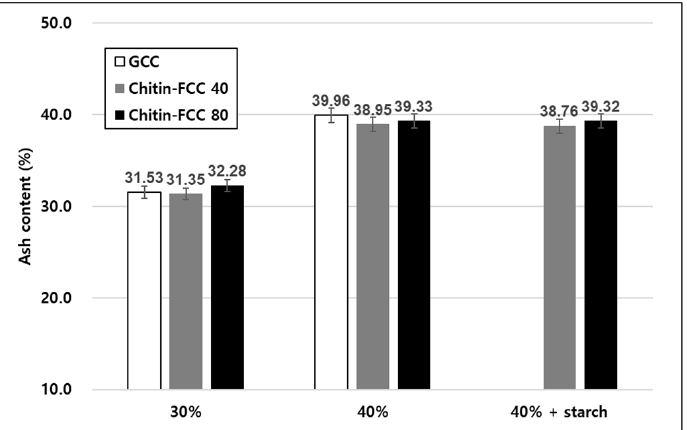
Figure 7. Experimental set of another type of handsheet with the ash content of the papers containing GCC, chitin-FCC, and chitin-FCC with starch.